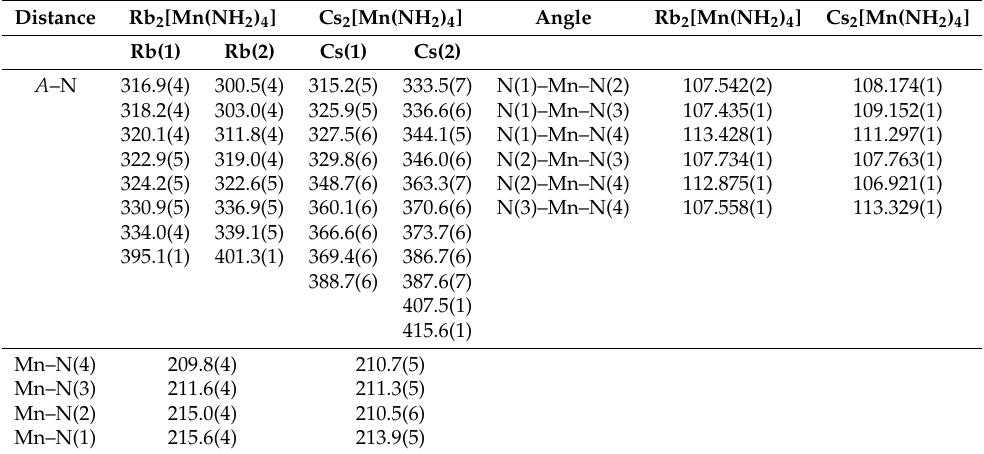
Table 3. Selected bond distances (in pm) and angles (in deg.) in HT-Rb 2 [Mn(NH 2 ) 4 ] and Cs 2 [Mn(NH 2 ) 4 ]. Distance